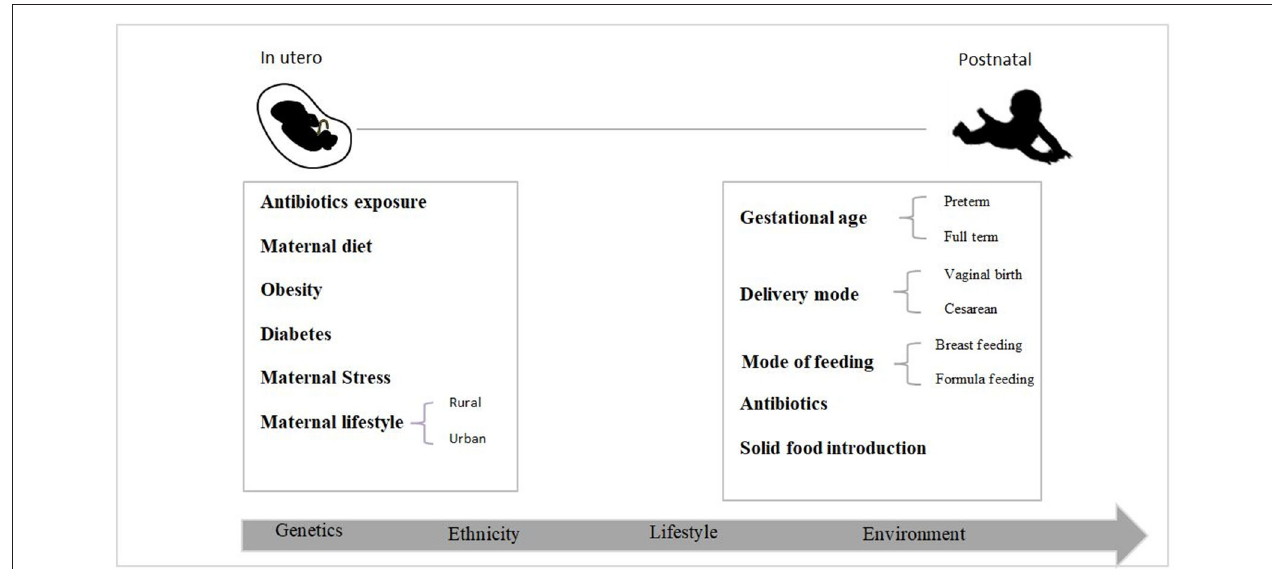
FIGURE 1 | Early life factors that impact the newborn gut bacteria colonization process.